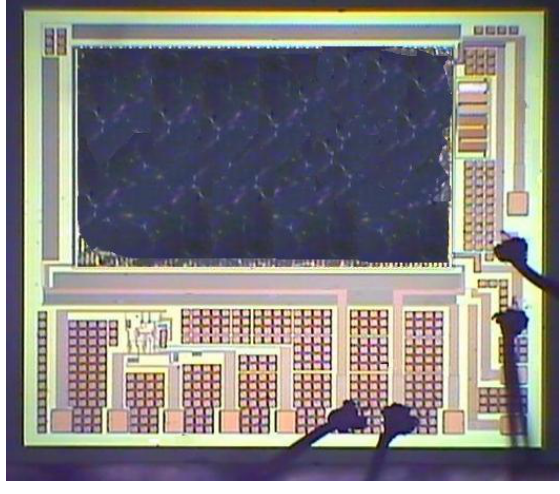
Figure 8. Optical image of the integrated ammonia sensor after the post-process.